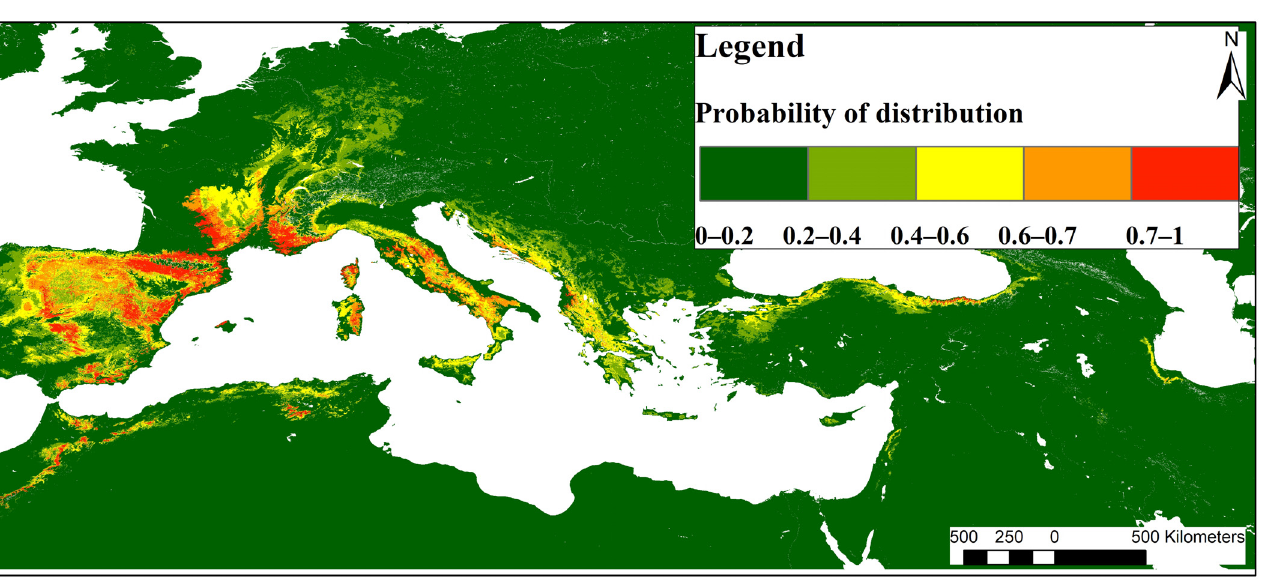
Figure 6. Jack-knife test for measuring the importance of each environmental parameter on the predicted distribution of the Montpellier Maple using MaxEnt.